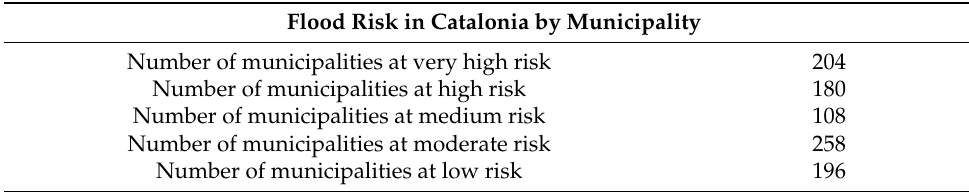
Table 14. Flood risk in Catalonia by municipality. Source: INUNCAT Plan, 2016. Flood Risk in Catalonia by Municipality Number of municipalities at very high risk 204 Number of municipalities at high risk 180 Number of municipalities at medium risk 108 Number of municipalities at moderate risk 258 Number of municipalities at low risk